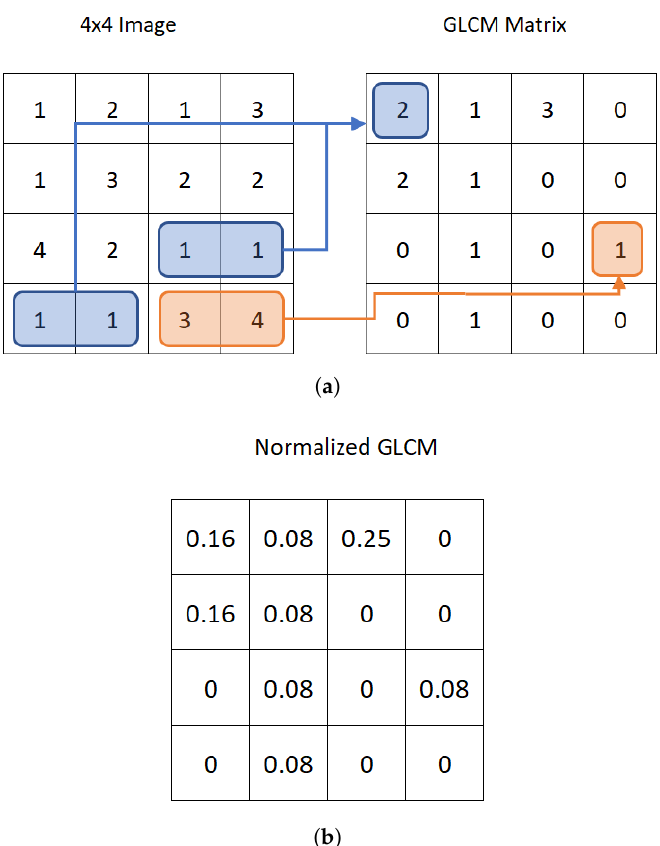
Figure 6. Design of the GLCM matrix from a 4 × 4 image with five gray intensity levels. ( a ) GLCM matrix with d = 1 and θ = 0; ( b ) The GLCM normalized